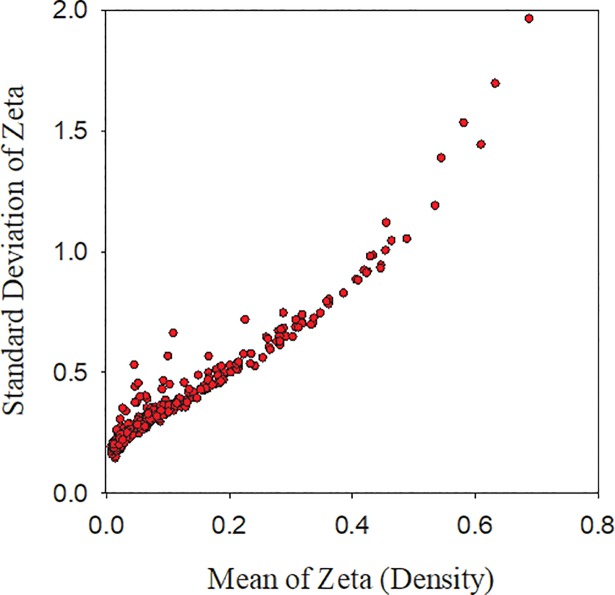
Network density vs. standard deviation of zeta for U.S. metropolitan areas.Increasing density (mean zeta) is correlated with increasing standard deviation of zeta driven by the appearance of rare and highly interdependent pairs of occupations.